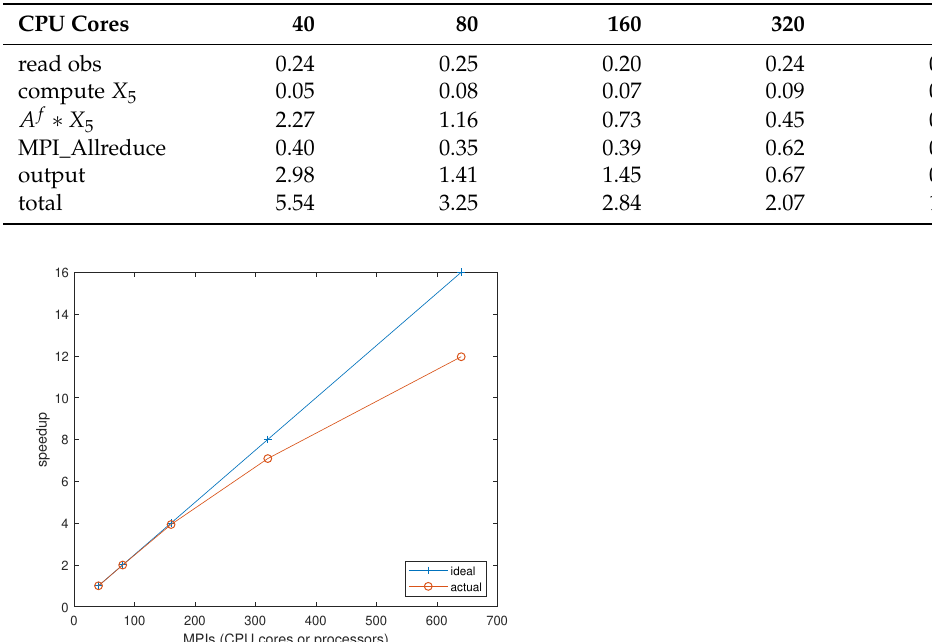
Table 8. The time allocation at the last analysis step for the unknown endpoint example (time unit: second).